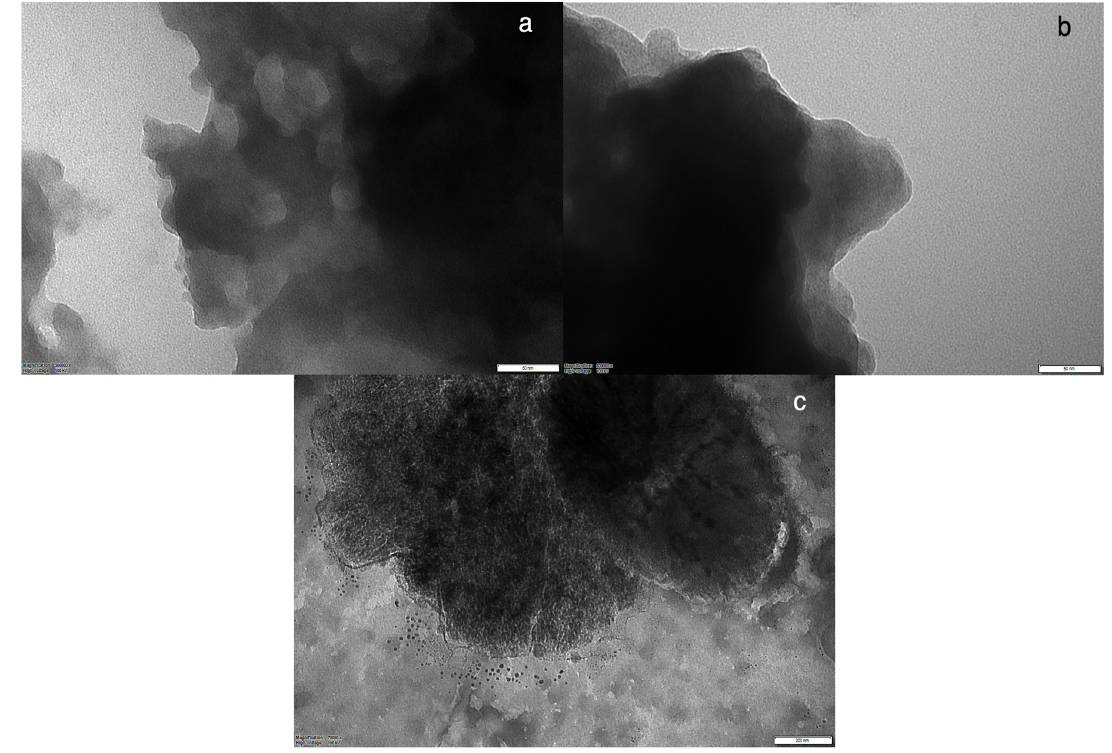
Figure 8. TEM images of graphene layers in sample ( a ) G-DMSO, ( b ) G-DMF, and ( c ) G-PA. Scale bar: ( a ) 50 nm, ( b ) 50 nm, and ( c ) 200 nm.